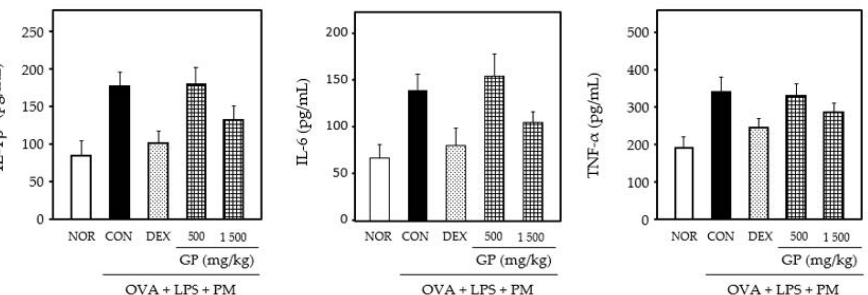
Figure 6. Anti-inflammatory effects of the GP. Generation of proinflammatory cytokines such as IL-1 β , IL-6 and TNF- α in OVA-, LPS- and PM-induced asthmatic rat model. Data are expressed as the means ± SD ( n = 5). A value of p -value < 0.05 was considered statistically significant.